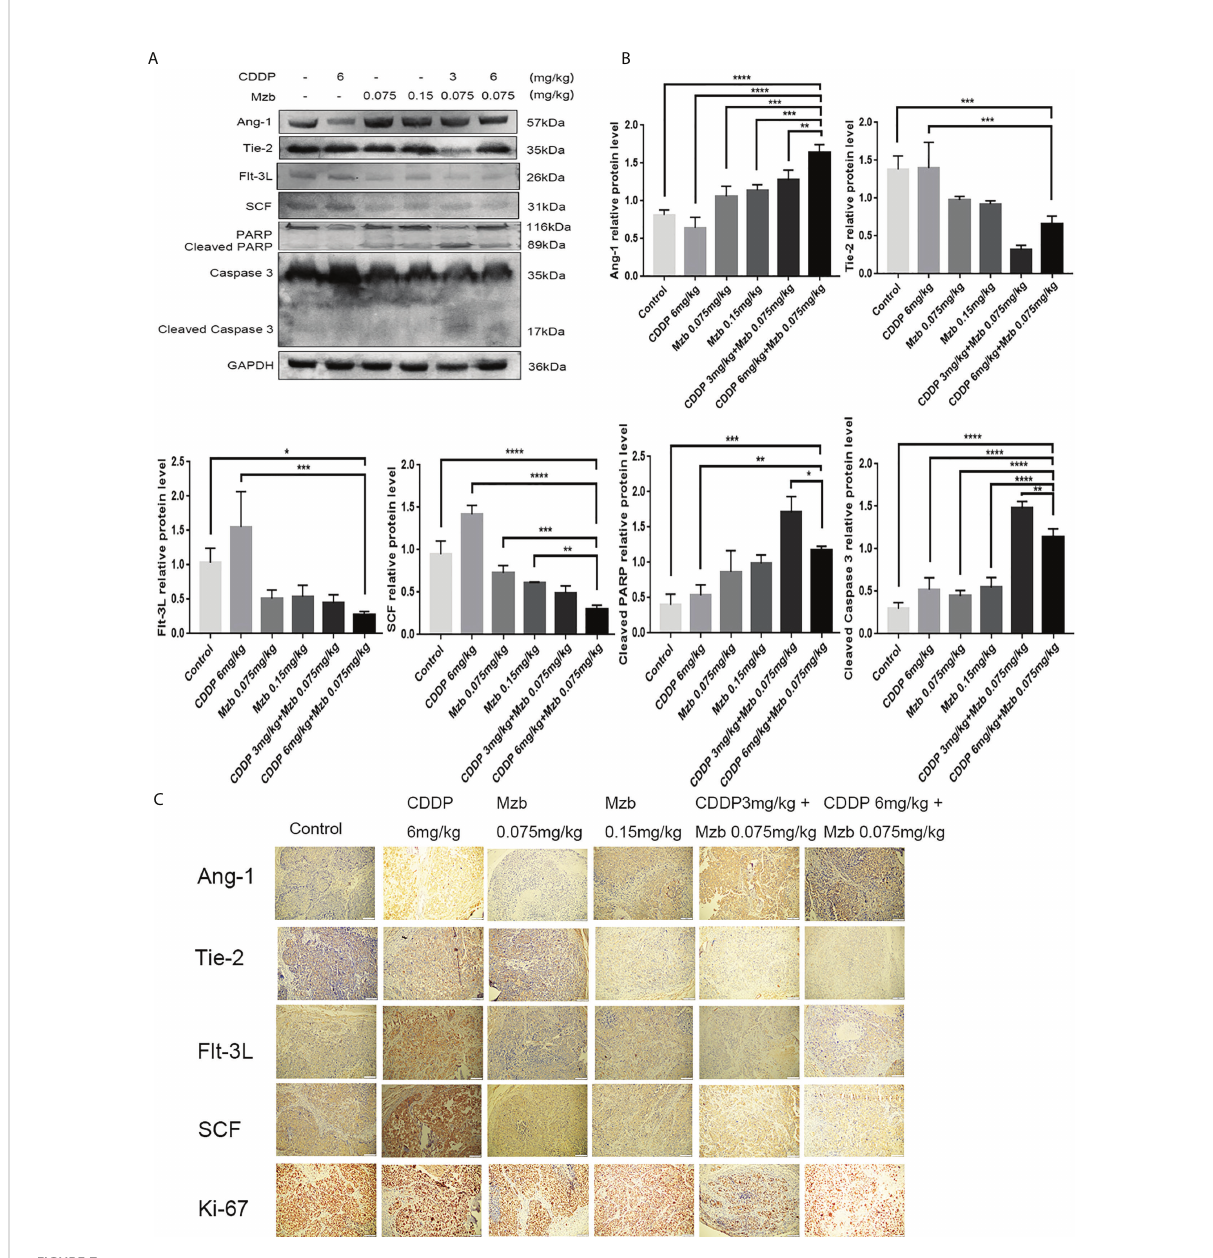
FIGURE 7 Molecular mechanisms of marizomib sensitized CDDP chemotherapy in HeLa cervical cancer xenografts that are relatively insensitive to CDDP. (A, B) The total tissue lysate was then run on SDS − PAGE and western blotted with antibodies against Ang-1, Tie-2, Flt-3L, SCF, PARP, and caspase 3. GAPDH was used as a loading control. *P<0.05, **P ≤ 0.01, ***P ≤ 0.001, ****P ≤ 0.0001, by ANOVA (Dunnett ’ s multiple comparison post-test). (C) Localization and expression of Ang-1, Tie-2, Flt-3L, SCF and Ki-67 in cervical